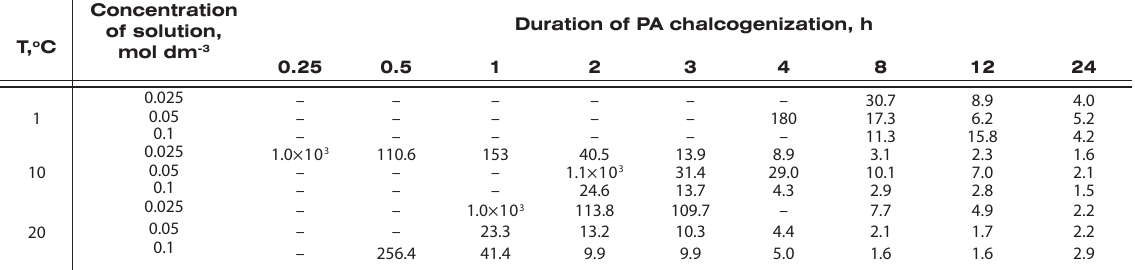
TeS O solution and then with Cu(II/I) salt solution 2 4 6